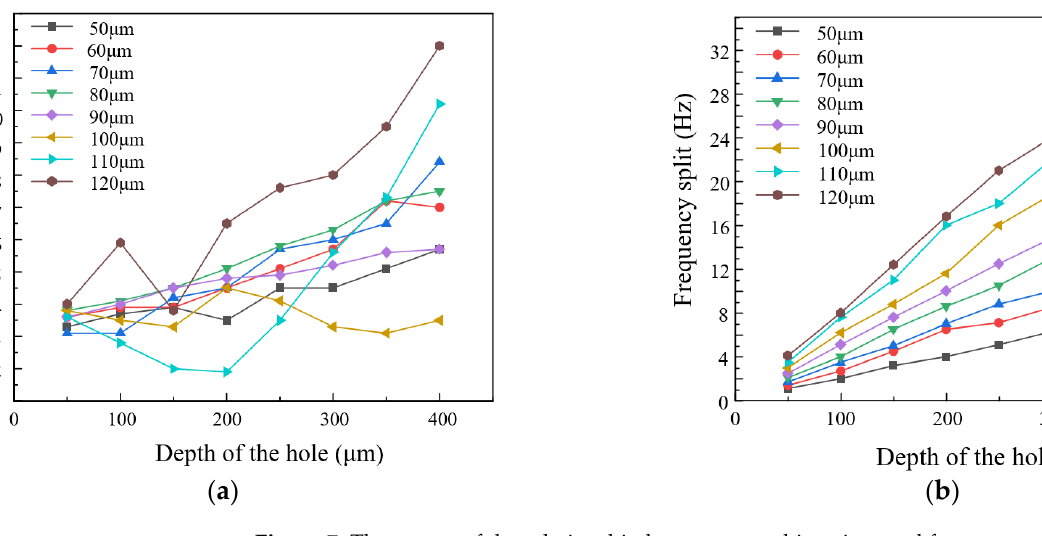
Figure 7. The curves of the relationship between punching sizes and frequency split. ( a ) Punch holes on the ring; ( b ) Punch holes on mass blocks .